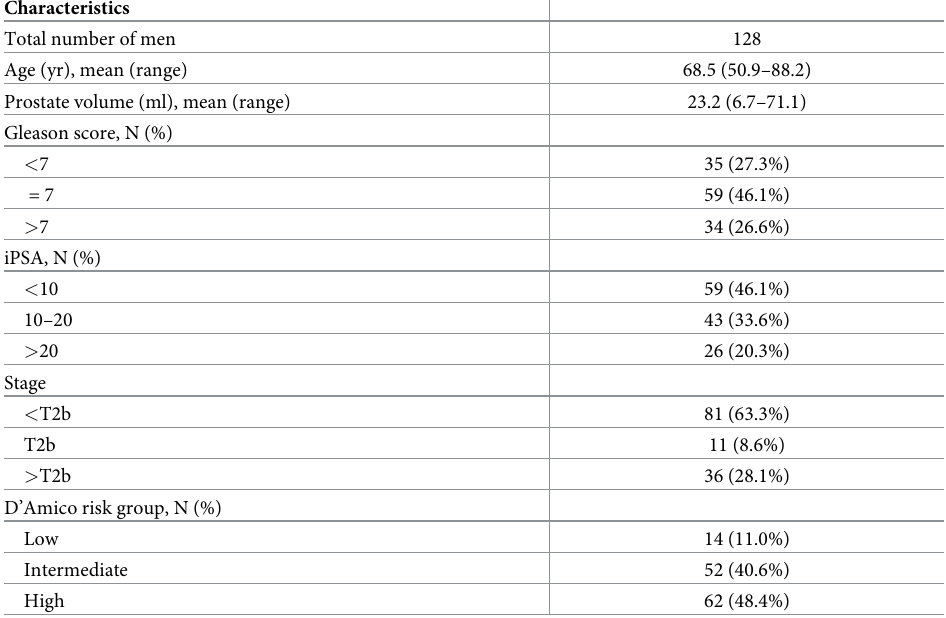
Table 1. Patient